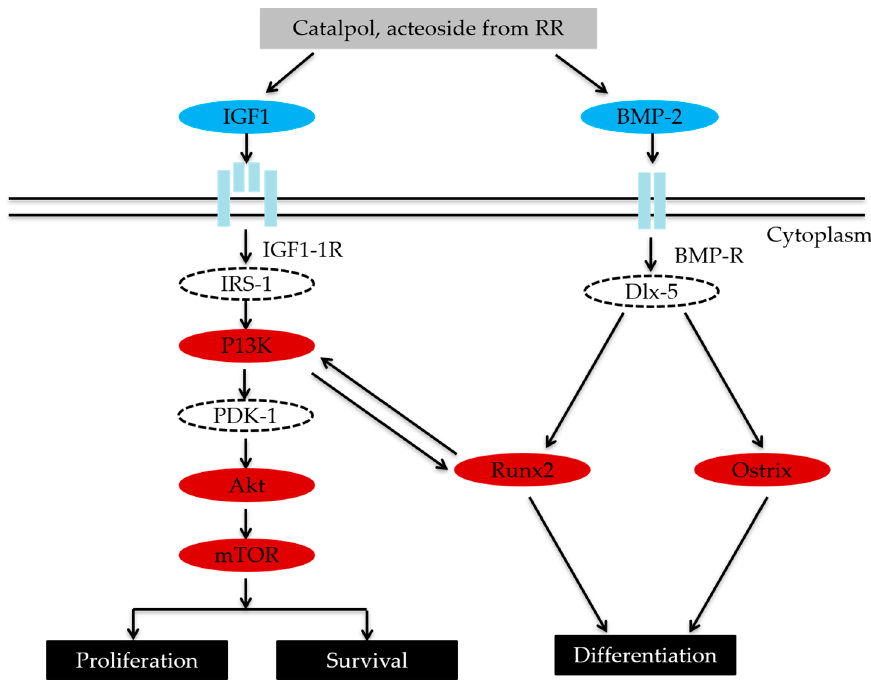
Figure 9. CAT and ACT from RR increased osteoblastic bone formation via BMP and IGF-I signal transduction pathways.